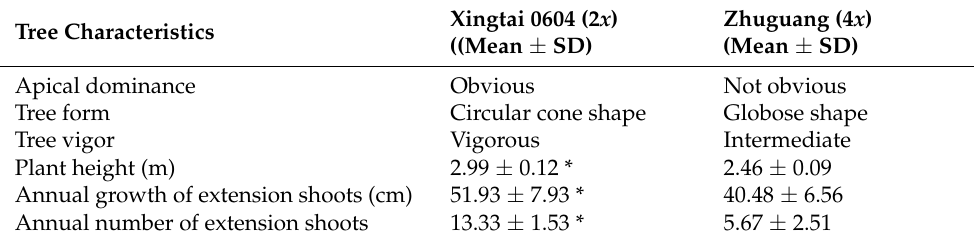
Table 1. Tree characteristics of ‘Xingtai 0604 (cid:48) and ‘Zhuguang’.